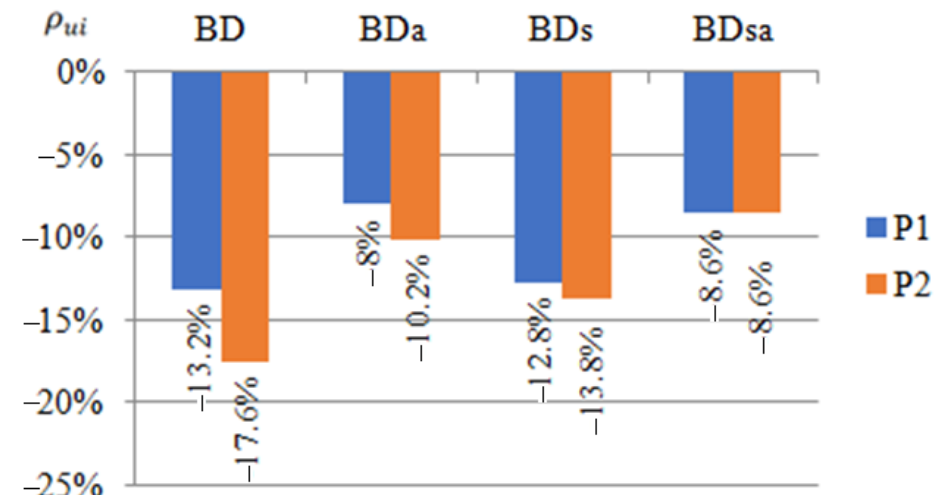
Figure 9. Percentage limits of deformation of reinforced beams in the upper flange. 348